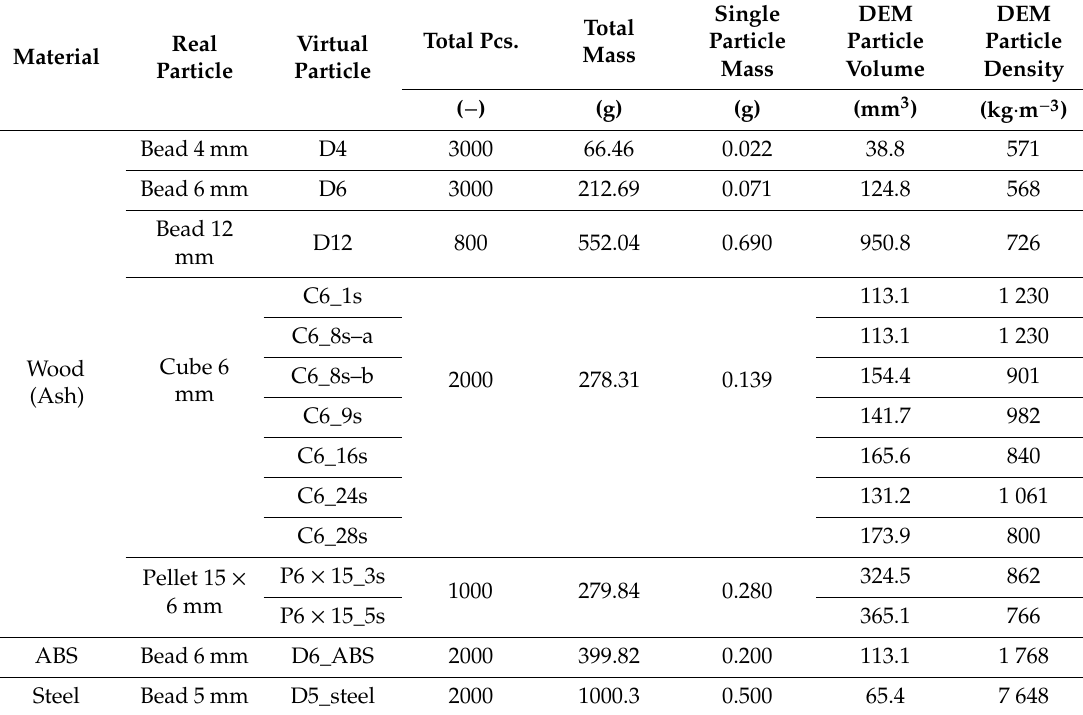
Table 3. Masses and densities of virtual